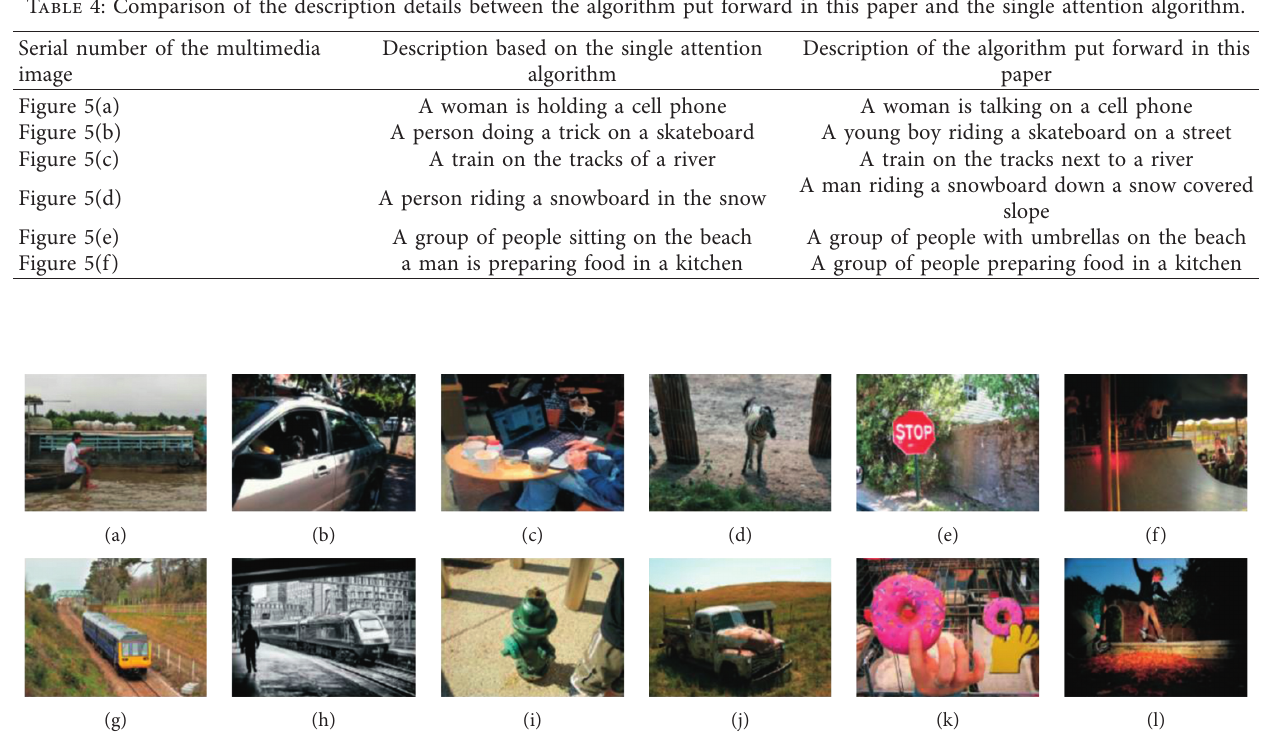
Figure 6: Test multimedia image selected for the testing of the algorithm put forward in this paper. (a) Folk style images (a fisherman). (b) Traffic image (a small car). (c) Life images (work and study). (d) Animal image (zebra). (e) Traffic image (a traffic sign). (f) Sports image (the sign of a skate park). (g) Traffic image (a train that is travelling). (h) Traffic image (a train station). (i) Public facility image (fire). (j) Environmental image (a dilapidated truck). (k) Life image (donut). (l) Sports image (skateboard stunt).